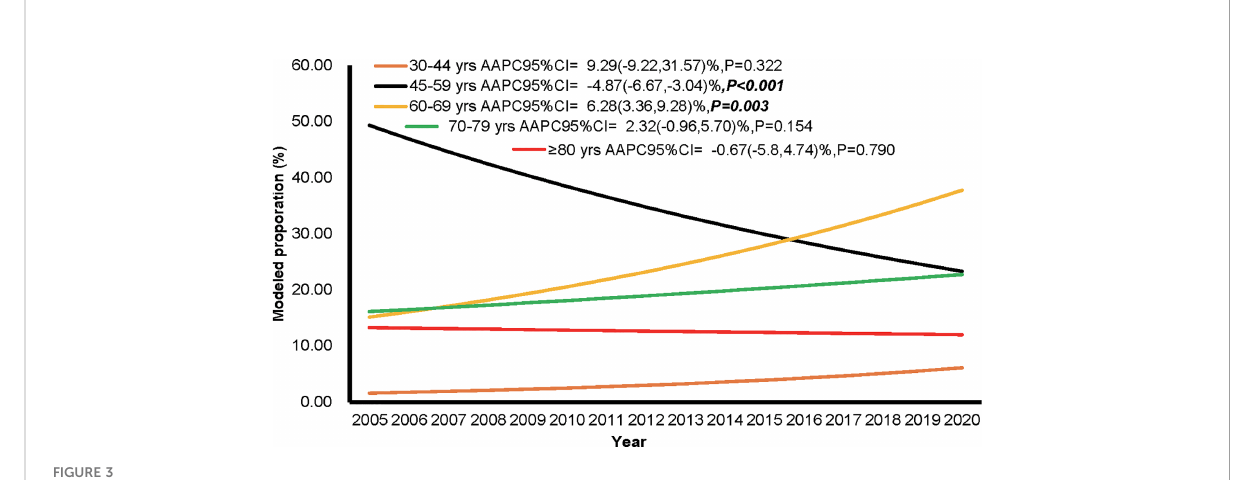
FIGURE 3 The proportion of individuals among different age groups during the period of 2005 to 2020 in Pudong New Area, Shanghai,